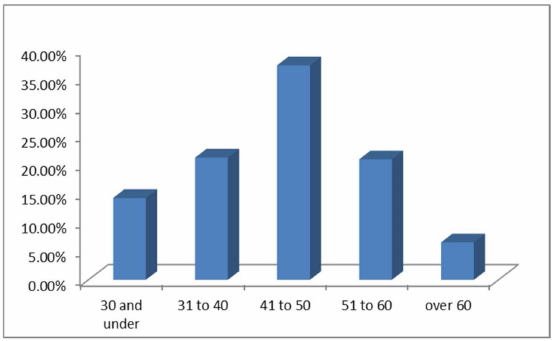
Figure 1. Sample distribution by age.